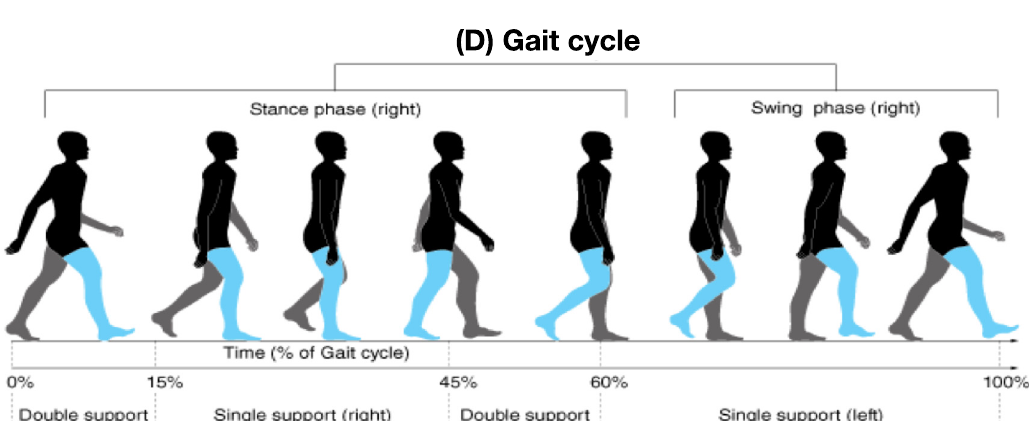
Fig 1. Measures of class overlap in feature space: (A) Abduction/adduction (B) Flexion/extension, and (C) Internal/external rotation. The signals were interpolated and resampled from 1% to 100% (100 points) of the gait cycle. Each red curve represents an OA subject and each blue curve represents an AS subject (D) The gait cycle phases. https://doi.org/10.1371/journal.pone.0202348.g001 PLOS ONE | https://doi.org/10.1371/journal.pone.0202348 October 1,